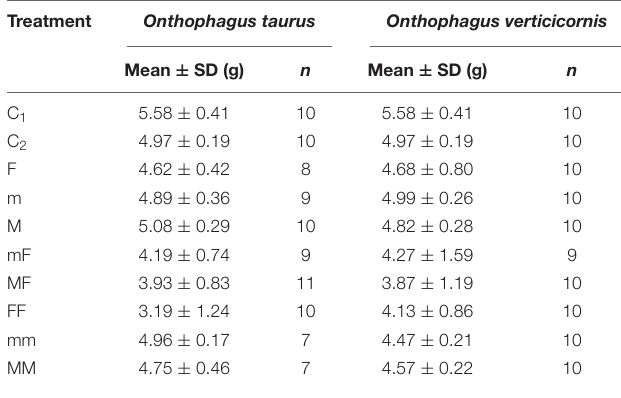
TABLE 1 | Mean dry weight of residual dung (g) and number of replicates for each species and treatment (C 1 , control at time 1; C 2 , control at time 2; F, one female; m, one minor male; M, one major male; mF, one female and one minor male; MF, one female and one major male; FF, two females; mm, two minor males; MM, two major